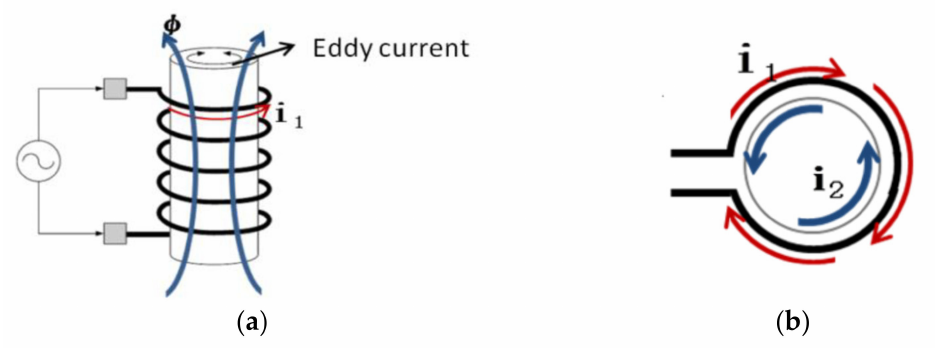
Figure 1. Induction heating mechanism [51]. ( a ) Magnetic flux by AC current i1 φ and ( b ) induced current (eddy current